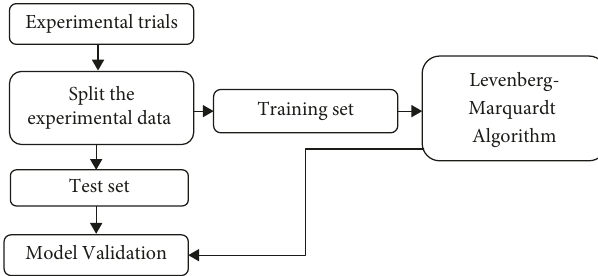
Figure 7: FFNN model flow